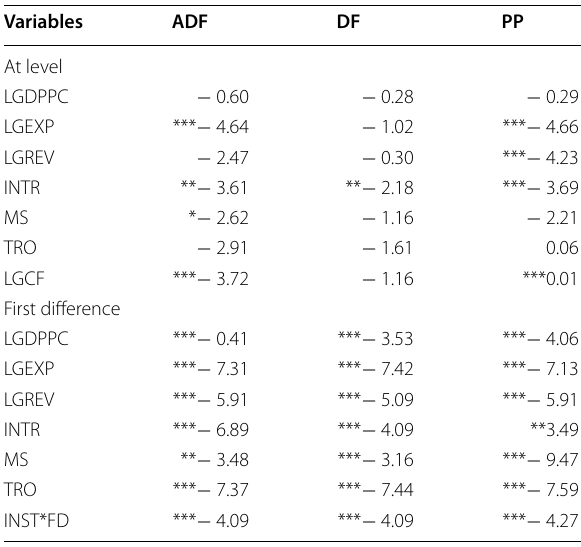
Table 3 Summary unit root